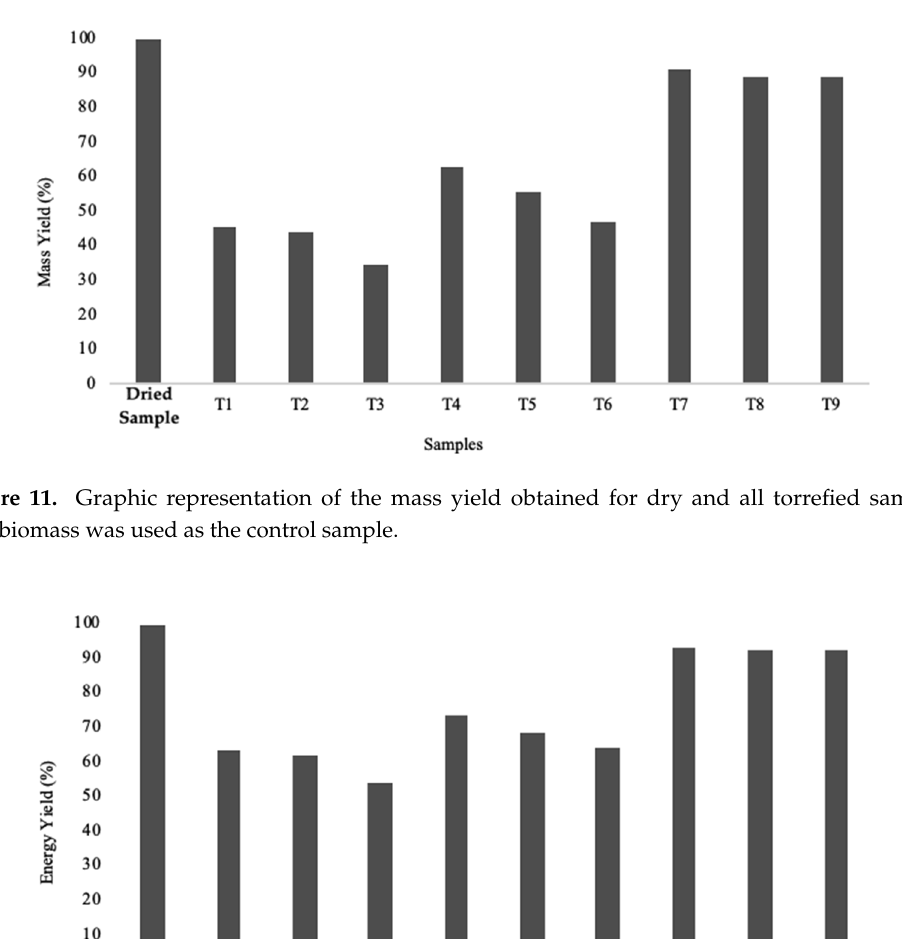
Figure 12. Graphic representation of the energy yield obtained for dry and all torrefied samples. Dry biomass was used as the control sample.